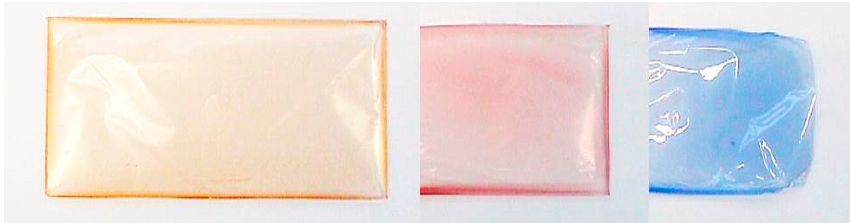
Figure 9. Cold water soluble films of dyed carboxymethylated xylan, cast from aqueous solutions.